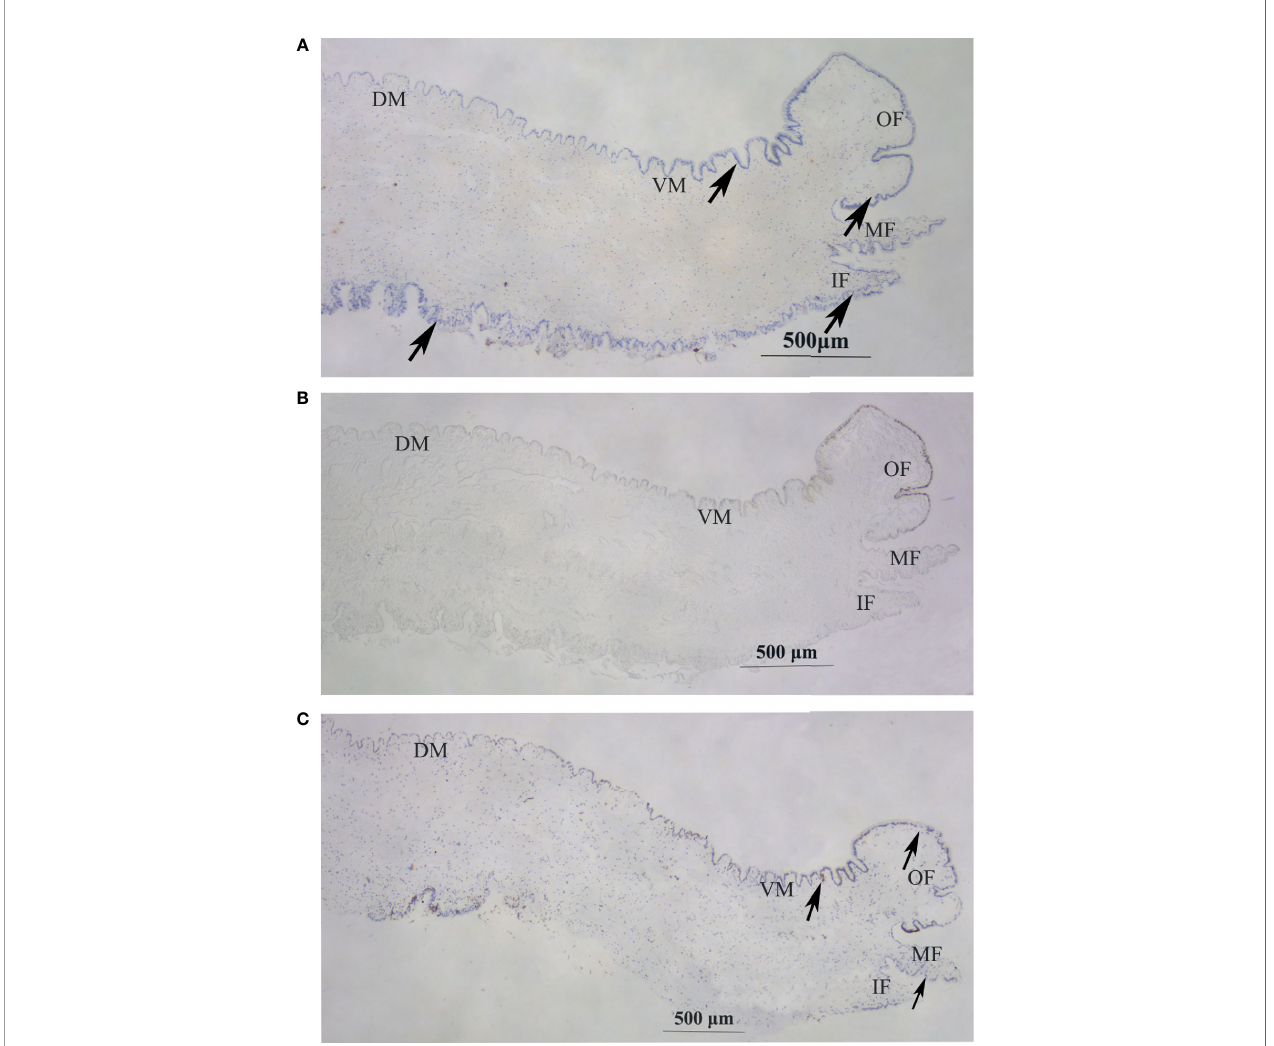
FIGURE 5 | In situ hybridization in the mantle of H. cumingii. (A) Signal of Hc-CDK6 in the experimental groups. (B) Micrograph of the control groups. (C) Signal of Hc- CCND2 in experimental groups. The arrow indicates the position of the signal. OF, outer fold; MF, middle fold; IF, inner fold; DM, dorsal mantle; VM, ventral